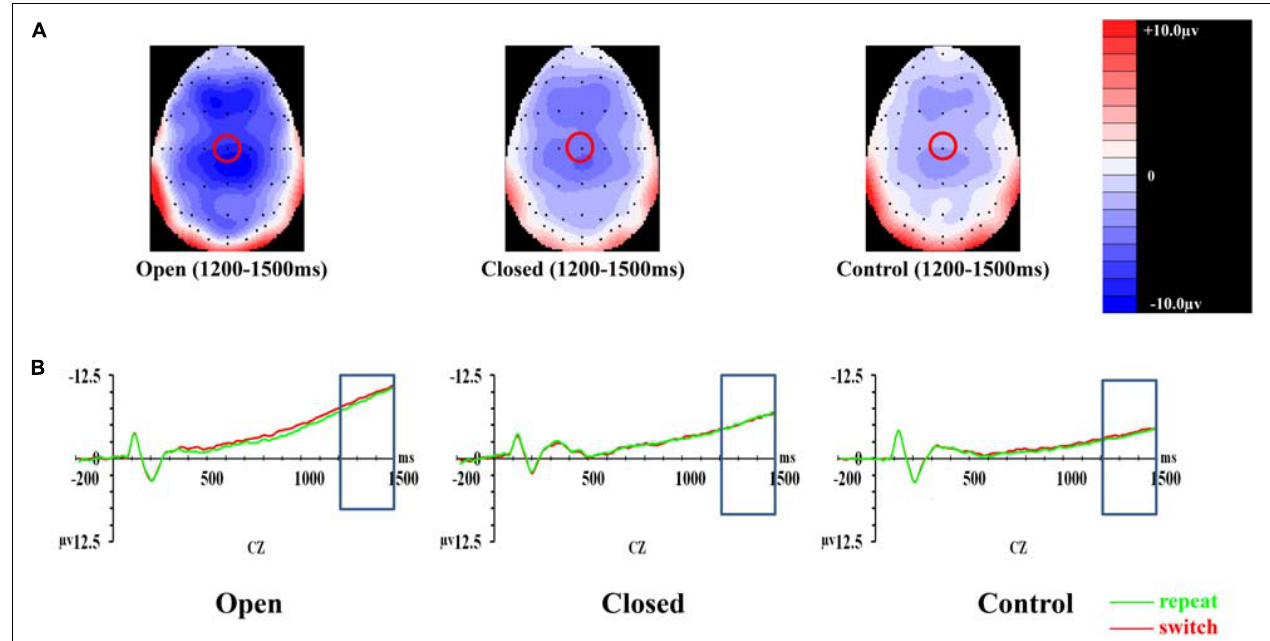
FIGURE 4 | Analyses of CNV among three groups of participants. (A) Topographical distributions within the 1000–1500 ms post-cue time-window regardless of trial types and validities; the Cz site is indicated with the red circle. (B) Mean amplitudes of the waveforms of the repeat (in green) and switch (in red) trial-types extracted at the Cz site regardless of validities; the 1000–1500 ms time-window is indicated with the rectangular boxes.